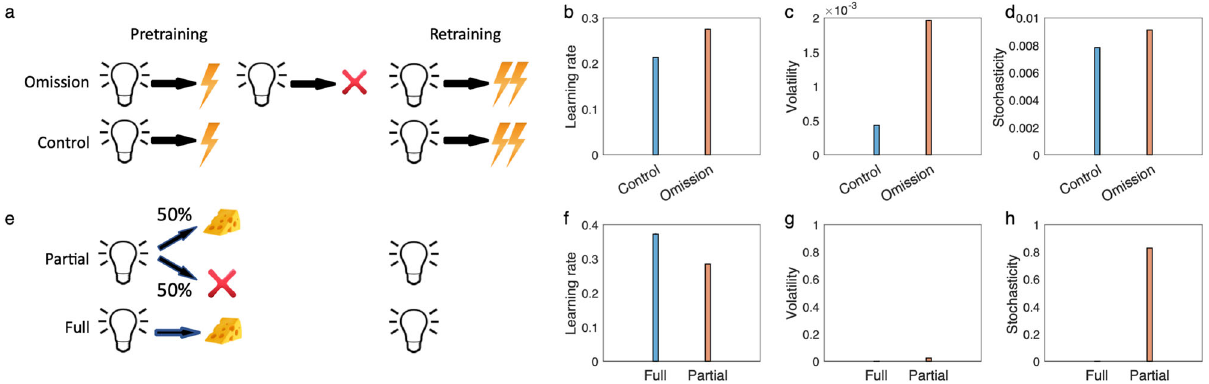
Fig. 2. Besides learning rates, an analogous insensitivity to vola- tility has been observed in pupil dilation 13 and in neural activity in the dorsal anterior cingulate cortex, a region that covaried with learning rate in controls 20